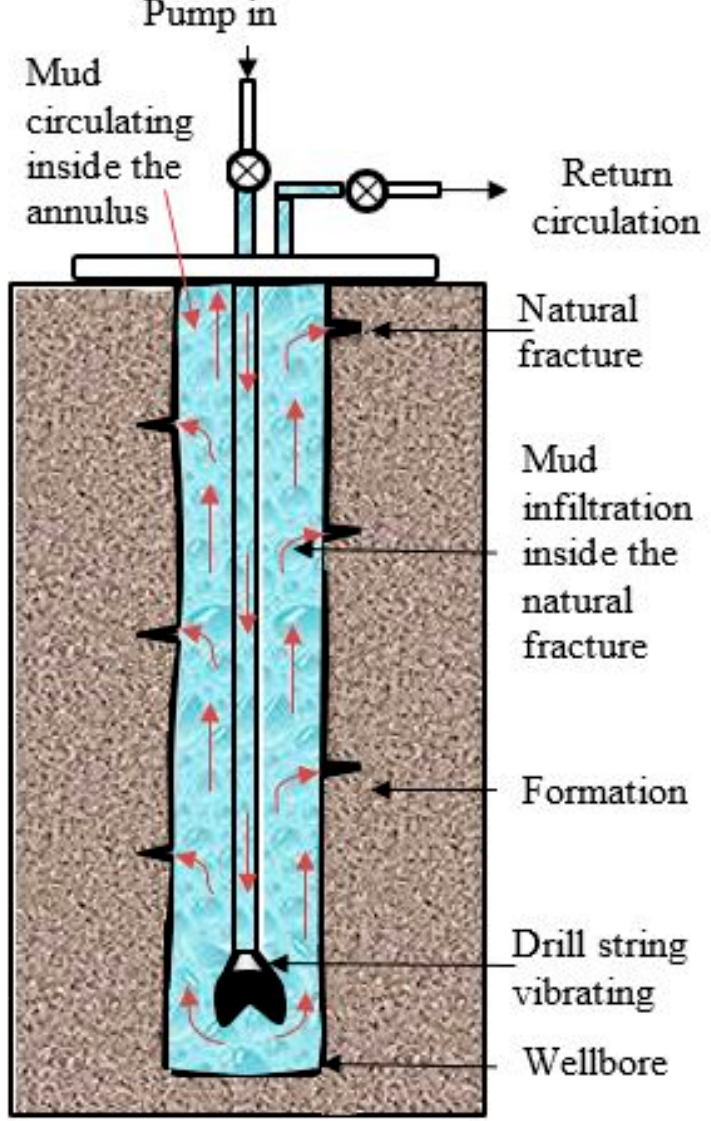
Figure 1. Illustration of the fluid flow inside the wellbore.